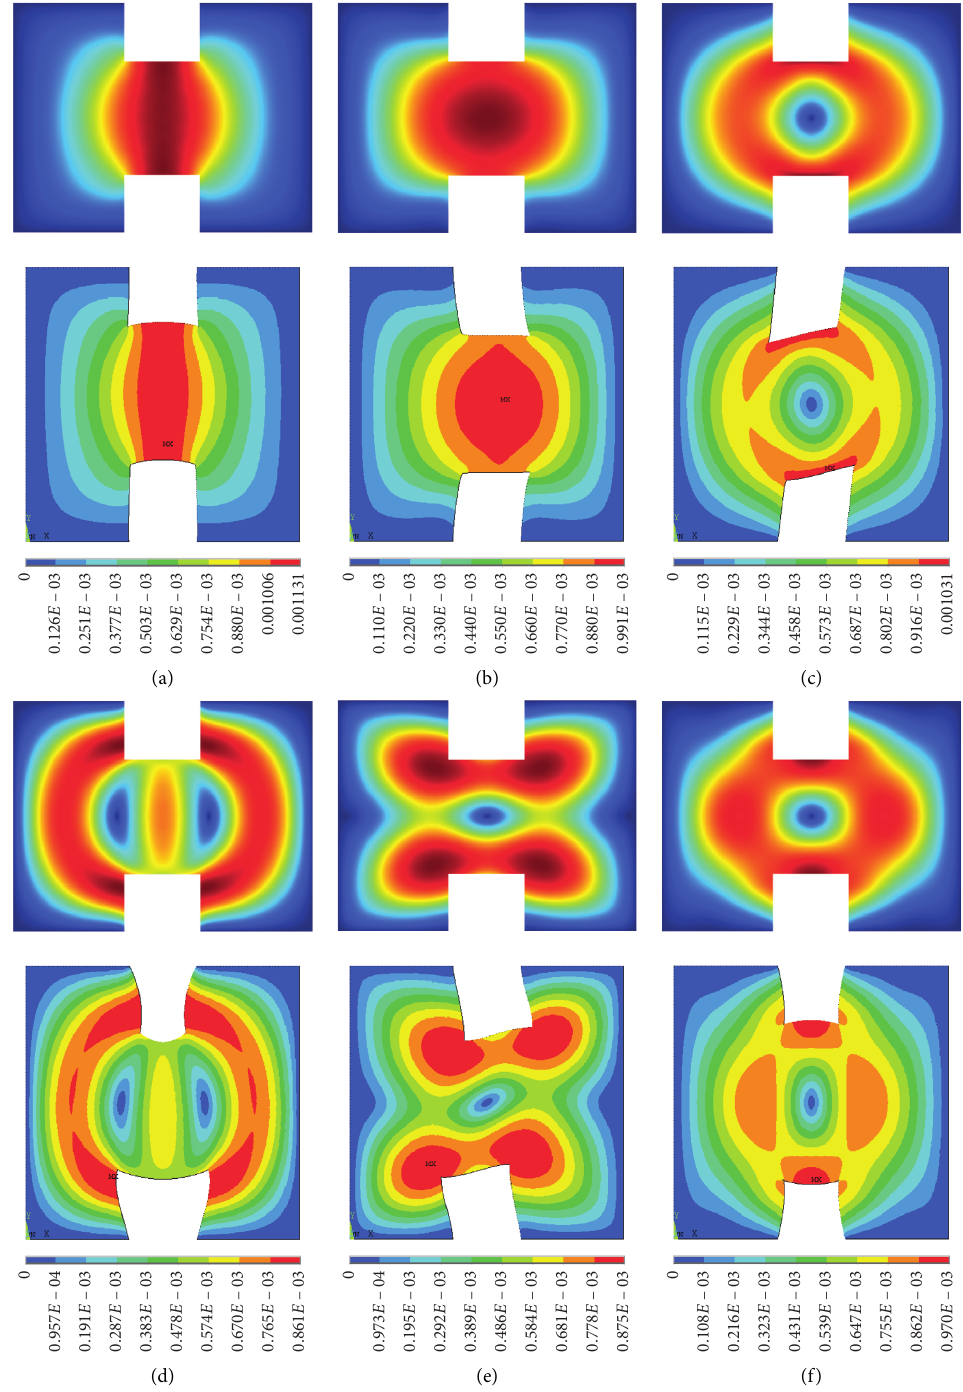
Figure 10: The first six mode shapes for the square plate with double edge cutouts. (a) The first mode; (b) the second mode; (c) the third mode; (d) the fourth mode; (e) the fifth mode; (f) the sixth mode. Upper: the present results; lower: the ANSYS